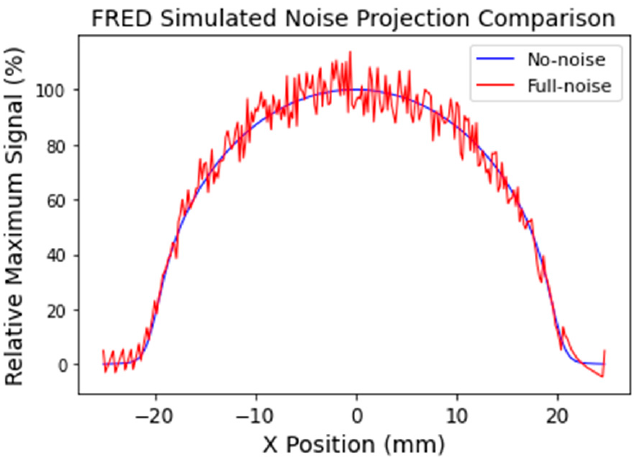
Figure 7. Comparison of no-noise- and full-noise-simulated projections. Profiles were taken from the no-noise and full-noise projection data at the depth of D max , indicating the difference in noise magnitude between the two simulations.